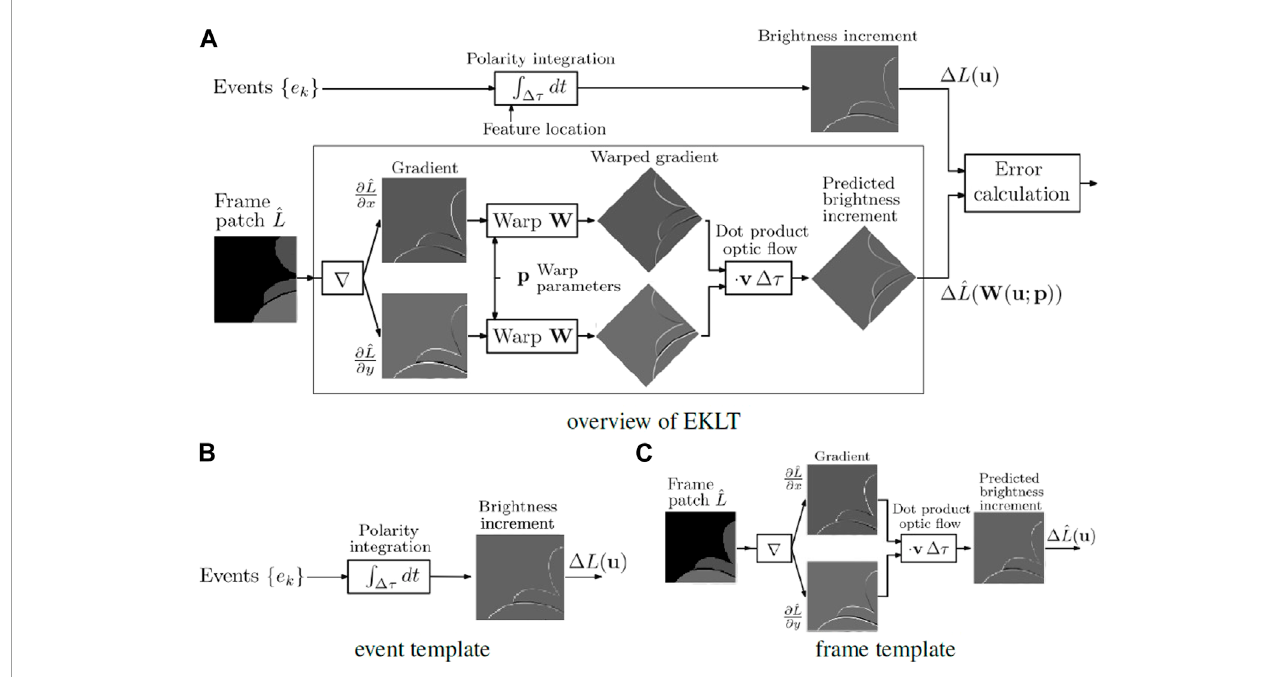
FIGURE 2 Block diagram of EKLT (A) , illustrating the comparison between brightness changes from images and events, adapted from (Gehrig et al., 2020). Comparison of the brightness change from event integration (B) , versus the brightness change from image gradient (C)